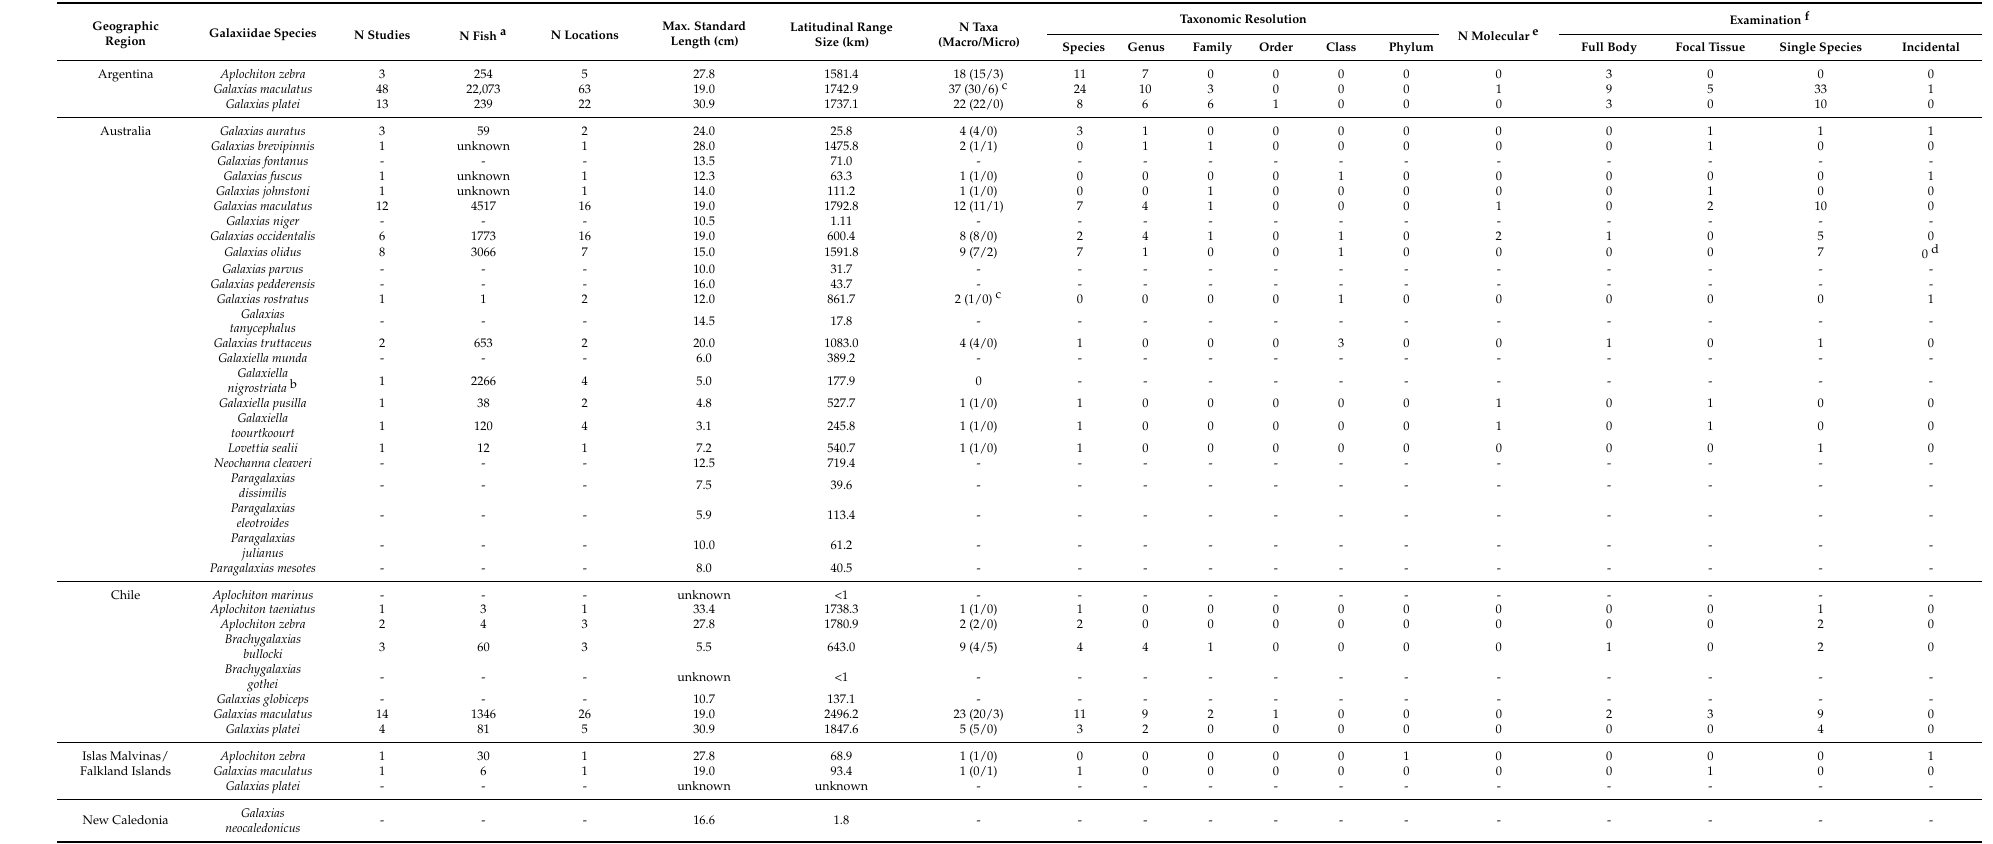
Table 1. Summary of parasitology studies from Galaxiidae